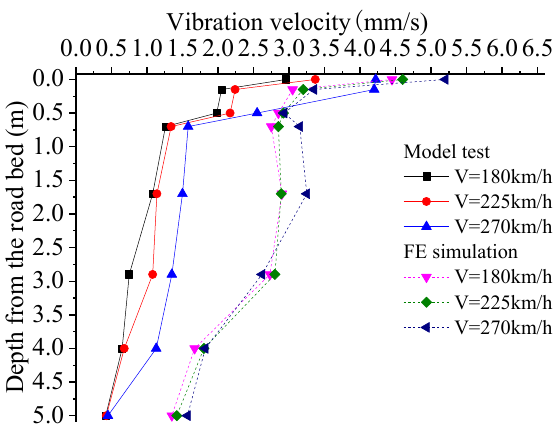
Figure 19. Distribution of the vibration velocity along the depth from the roadbed.